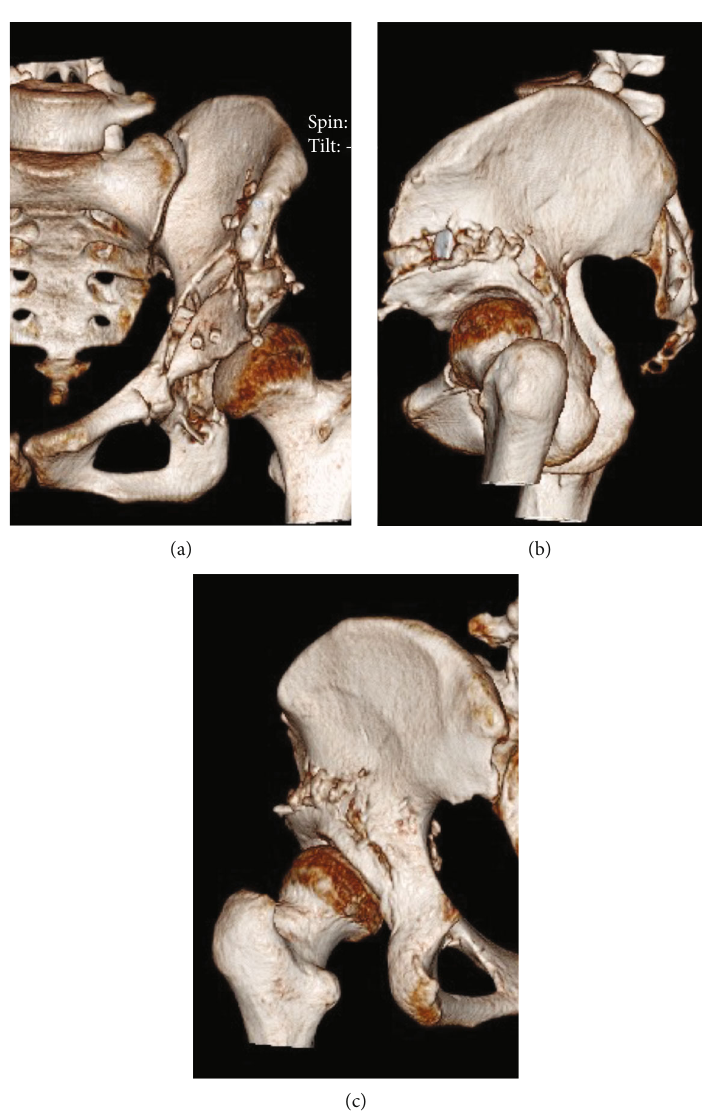
Figure 2: CT images taken one week after surgery: (a) frontal view, (b) sagittal view, and (c) posterior view. There was no fracture of the posterior column, and since the pubis was not completely osteotomized, there was no penetration of the osteotome into the joint, and the pubis was not completely cut. The pelvic ring has been